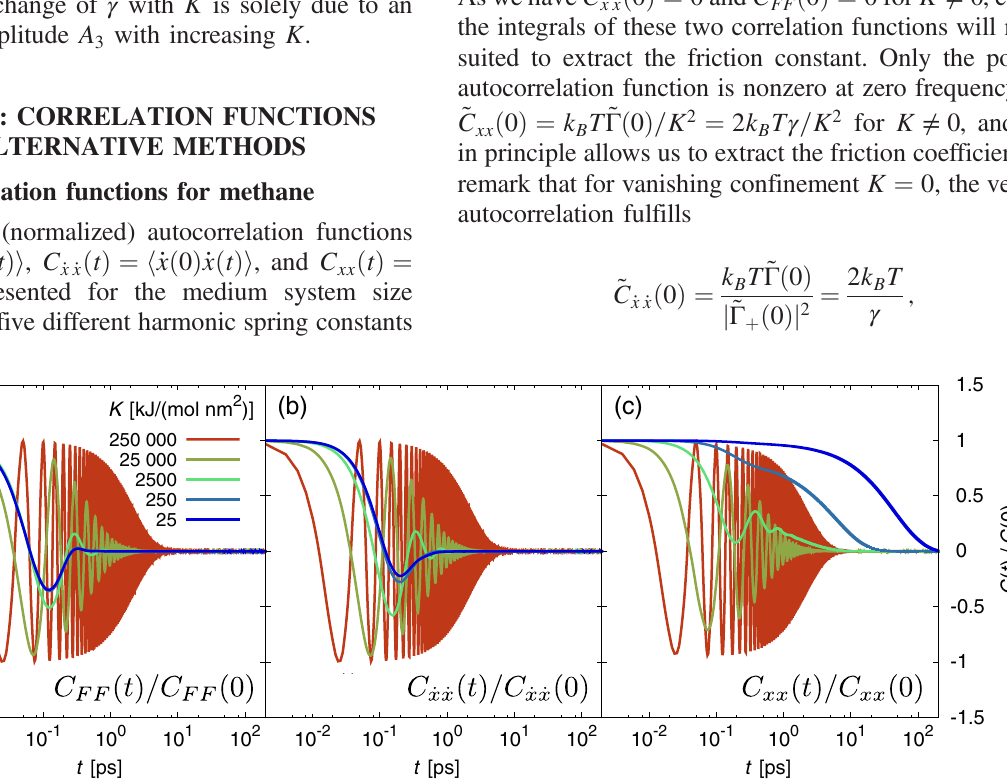
FIG. 11. The normalized autocorrelation functions C L ¼ 4 . 5 nm and five different spring constants K of the harmonic